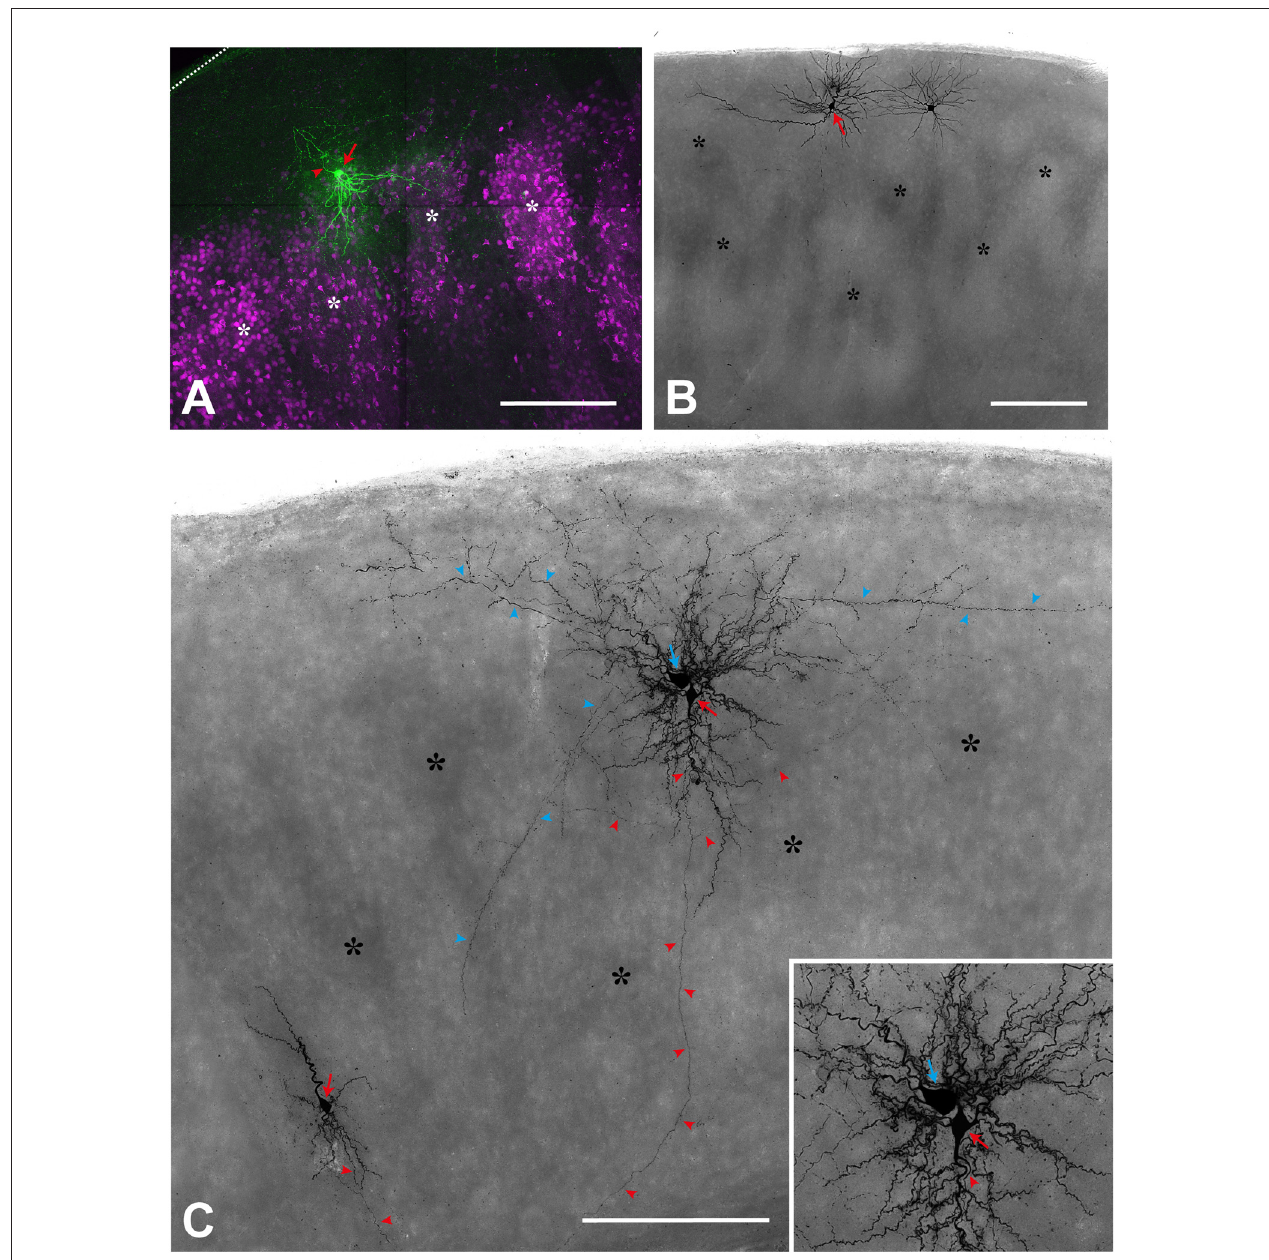
FIGURE 2 | Single cell fillings show the aberrant morphology of several types in the reeler cortex. (A) Regular-spiking spiny stellate cell ( red arrow ), located on top of two barrel equivalents ( asterisks ; labeled by Sccn1a-cre/tdTomato; see Guy et al., 2015, 2016). Please note that the dendrites spread out in a V-shaped manner to reach to neighboring cell clusters whereas the axon ( red arrowhead ) initially is directed toward the pial surface ( dashed line ). (B) Repetitive-bursting (probably “L Vb”) pyramidal cell ( red arrow ) with a horizontally-oriented apical dendrite. (C) Cortical slice, in which three neurons have been recorded and labeled. A small up-right, regular-spiking pyramidal cell ( red arrow ; lower left), whose axon ( red arrowheads ) is directed toward the white matter. An inverted regular-spiking pyramidal cell ( red arrow ; see inset for details) shows an axon ( red arrowheads ) originating from the apical dendrite, which points toward the white matter). Directly next to it, a fast-spiking large basket cell ( blue arrow ) is labeled, whose axon ( blue arrowheads ), in addition to many local collaterals, issues divergent axonal projections. Scale bars: (A) —100 µ m; (B,C) —250 µ m.